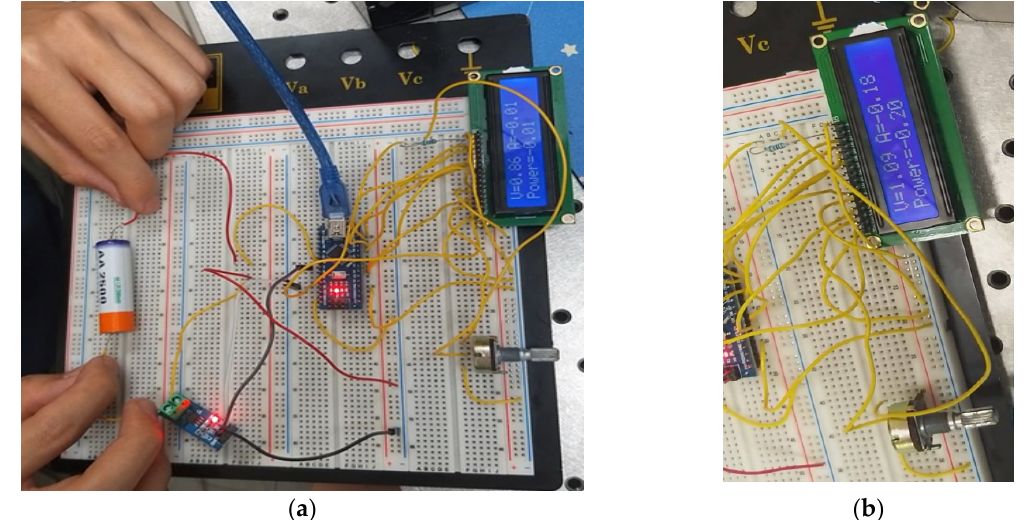
Figure 19. Arduino nano board dynamometer. ( a ) Ni–H battery before charged, ( b ) Ni–H battery charged after one hour.